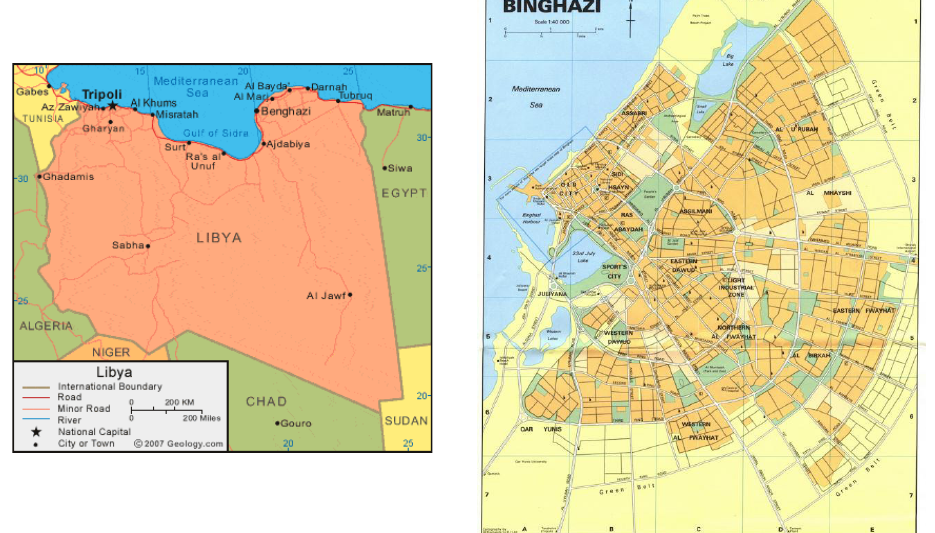
Figure 2. Location of Benghazi (Geology, 2005; Ball State University, Libya Maps, 2012)